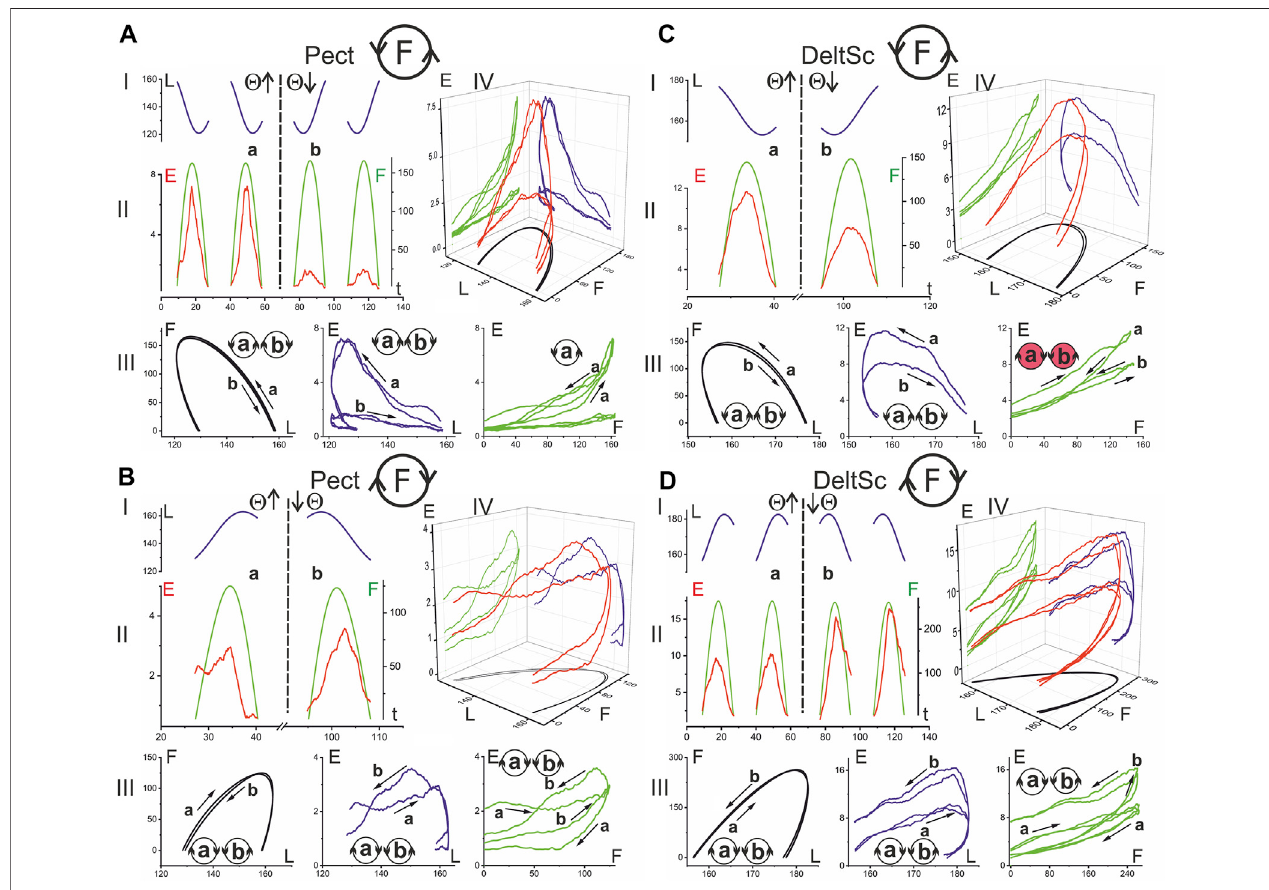
FIGURE6| The hysteresiseffectsin theactivity oftheshouldermuscles.Thedatawereobtainedinthesameexperiment asin Figure5 ; combining both drawings proved impractical due to their scope. The structure of the plots and all the designations (except for the names of muscles) are the same as in Figure 5 .